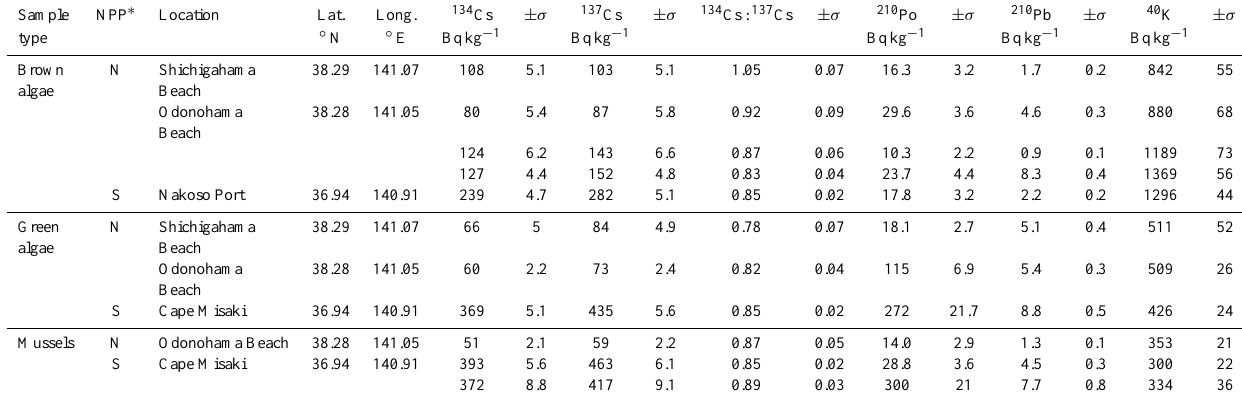
Table 1. Dry-weight-based concentrations of 134 Cs, 137 Cs, 40 K and 210 Po in macroalgae and mussels sampled in June 2011 along the east coast of Japan. Activities were decay-corrected to the date of sample collection, except for 40 K given its very long half-life (1.25 × 10 9 yr). σ is the propagated counting error (Bqkg − 1 )